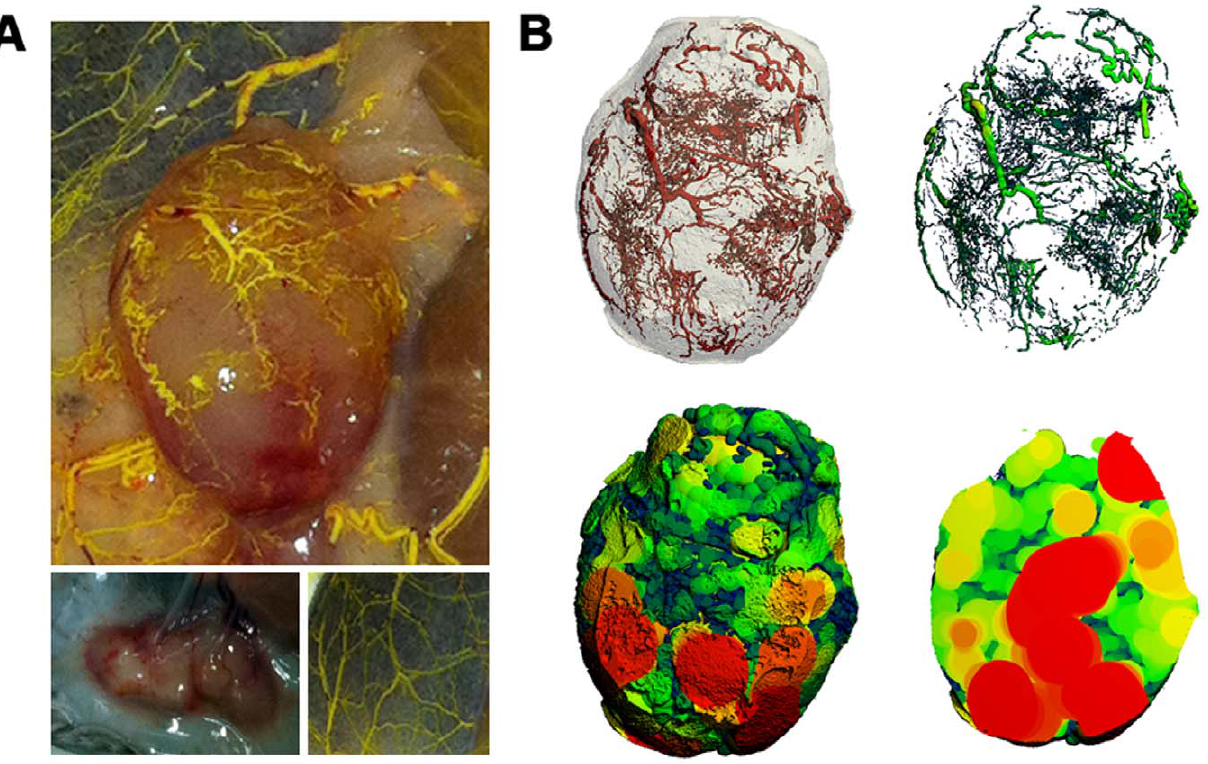
Figure 1. Microfil combined with micro-CT. ( A ) Image of a Microfil-perfused tumor grown subcutaneously in a mouse (top). The Microfil polymer is yellow, allowing one to visualize the effectiveness of the perfusion. Images of a non-perfused tumor (bottom left), and of the perfused dermis without a tumor (bottom right) are included as a control. ( B ) 3-D reconstructions of the tumor in ( A ) showing a surface rendering of the vasculature (top left), the thickness of the vessels demonstrated by a heat map and the intravascular distances (top right), or vessel separation demonstrated with a sphere-filling model (bottom left – full view, bottom right – cross-section through centre of tumor). Note that the vessels are not shown in the sphere-filled images, only the inter-vessel spaces.